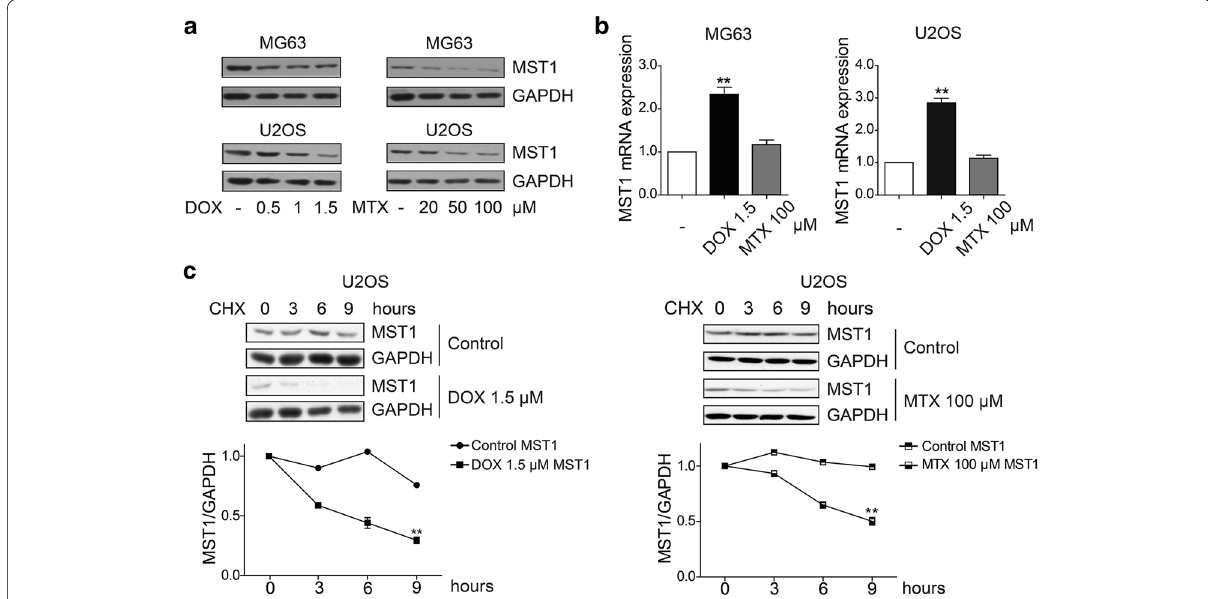
Fig. 5 MTX and DOX decrease mammalian sterile 20‑like kinase 1 (MST1) expression by altering its protein stability. a Western blotting representa‑ tive image of mammalian sterile 20‑like kinase 1 (MST1) total protein level in MTX‑ or DOX‑treated osteosarcoma cells. MST1 protein level was decreased by MTX and DOX. b The MST1 mRNA levels in the control and MTX‑ or DOX‑treated osteosarcoma cells were monitored via real‑time polymerase chain reaction using specific primers. The error bars represent mean SD. Compared with control ( t test, n 3), ** P < 0.01. MST1 ± = mRNA did not decrease after MTX or DOX treatments. c U2OS cells were treated with 100 μg/mL of cycloheximide for the indicated periods. The endogenous MST1 protein levels were determined by western blotting ( upper panels ), and relative MST1 protein levels were normalized to those of GAPDH ( lower panels ). The error bars represent mean SD. Compared with control (paired t test, n 3), ** P < 0.01.MST1 degradation was increased ± = by MTX and DOX in U2OS cells. CHX cycloheximide